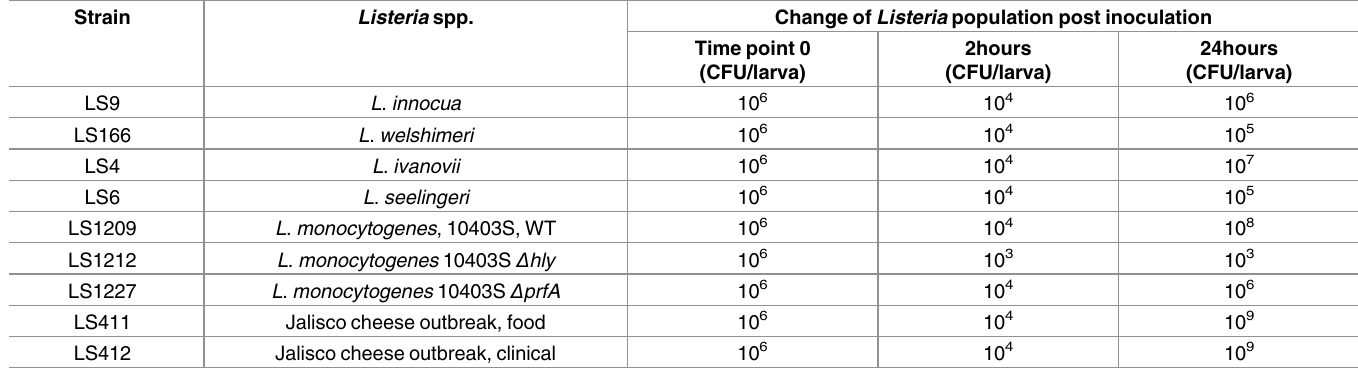
Table 2. Change of Listeria population following inoculation * . Strain Listeria